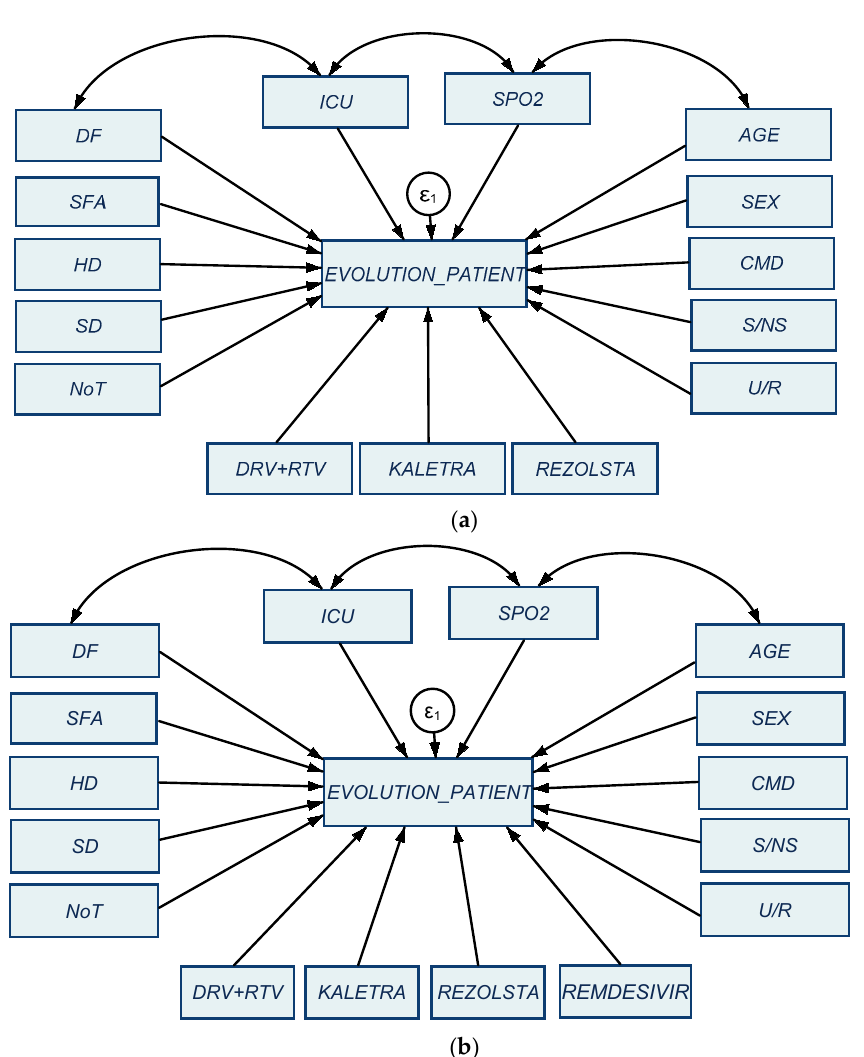
Figure 1. General configuration of the SEM models: ( a ) first sample of 145 COVID-19 patients from the first wave; ( b ) second sample of 129 COVID-19 patients from the second wave. Source: Own configuration in Stata 16.